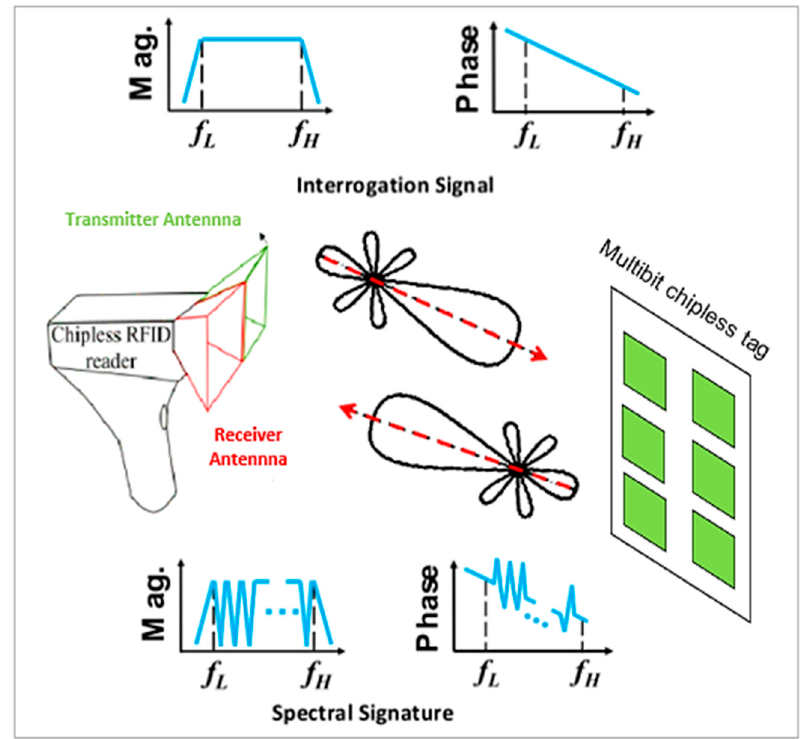
Figure 1. Operation principles of the chipless radio frequency identification (RFID) system.